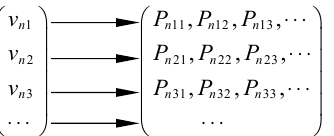
Figure 4. Mapping relationship between wind speed and power.